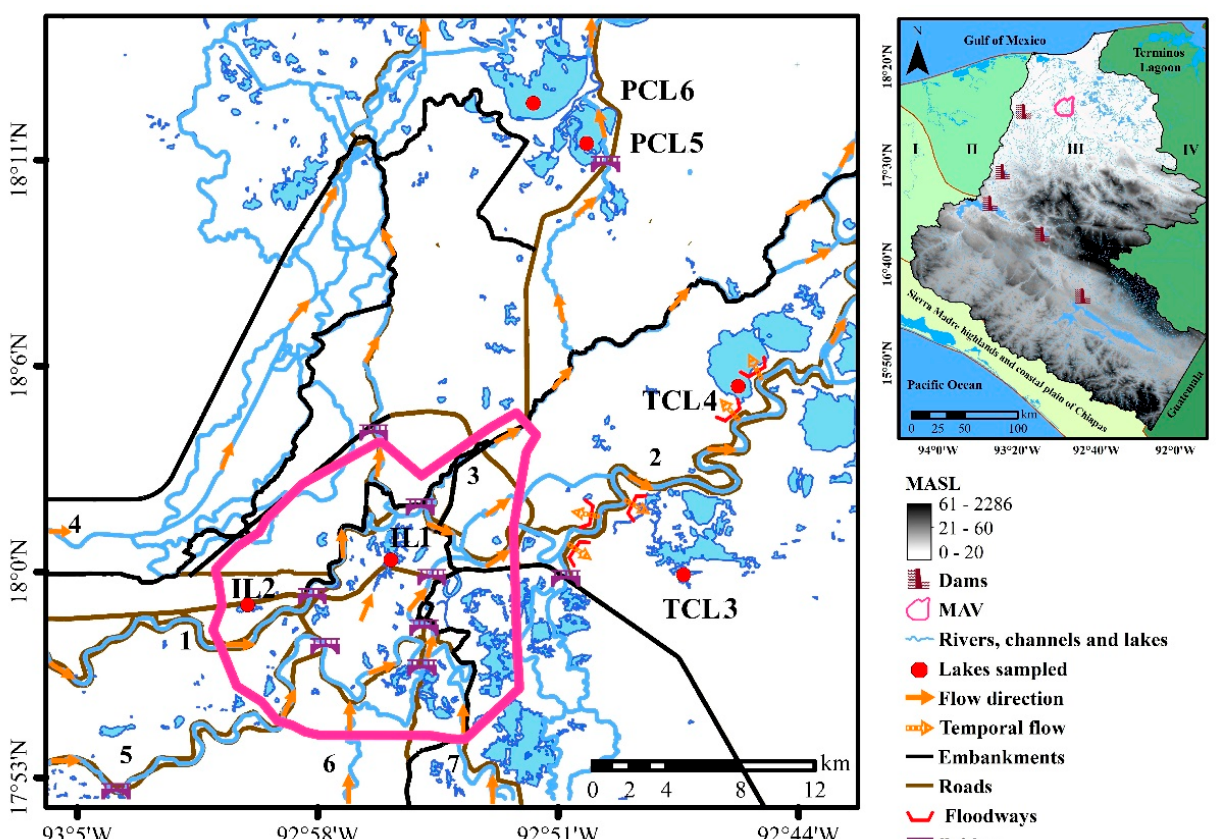
Figure 1. Location of the study area in the Grijalva River basin (III) and surrounding basins (I = Coatzacoalcos, II = Tonala, IV = Usumacinta). Distribution and configuration of lakes in the Metropolitan Area of Villahermosa (MAV) and the surrounding rural areas in the floodplain. (1) Carrizal River, (2) Grijalva River, (3) Medellin-Gonzalez River, (4) Samaria River, (5) Mezcalapa Viejo River, (6) Pichucalco River, (7) La Sierra River. IL1 = Las Ilusiones, IL2 = Loma de Caballo, TCL3 = Playa del Pozo, TCL4 = Maluco, PCL5 = Manguito, PCL6 = Pucte. MASL = meters above sea level.